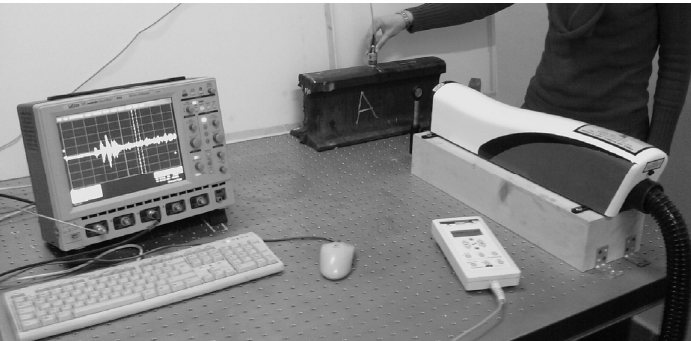
Figura 5: Foto del setup sperimentale per lo studio del fungo della rotaia.